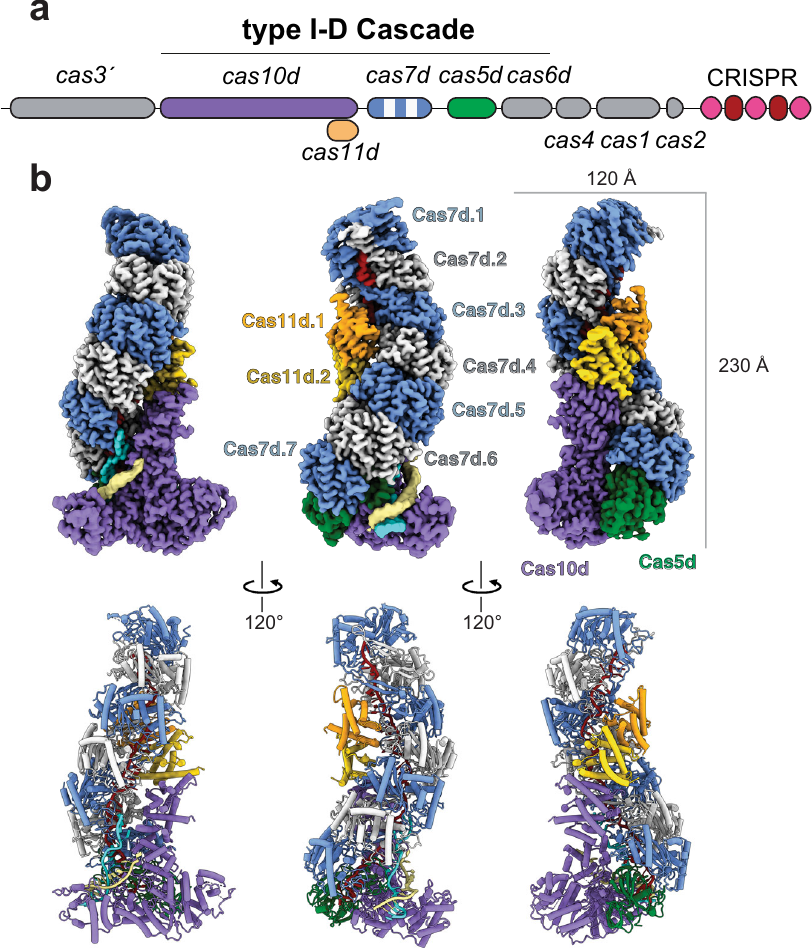
Fig. 1 Architecture of type I-D Cascade. a Schematic of the type I-D CRISPR-Cas operon. Subunits and nucleic acids are colored as follows: Cas10d, purple; Cas5d, green; Cas7, blue and white; Cas11d, gold and orange; TS, khaki; NTS, cyan; crRNA, red. Subunits not present in our structures are colored gray in the operon. b Cryo-electron microscopy reconstruction at 2.9 Å resolution (top) and corresponding atomic model (bottom) of type I-D Cascade. Components are colored as in a